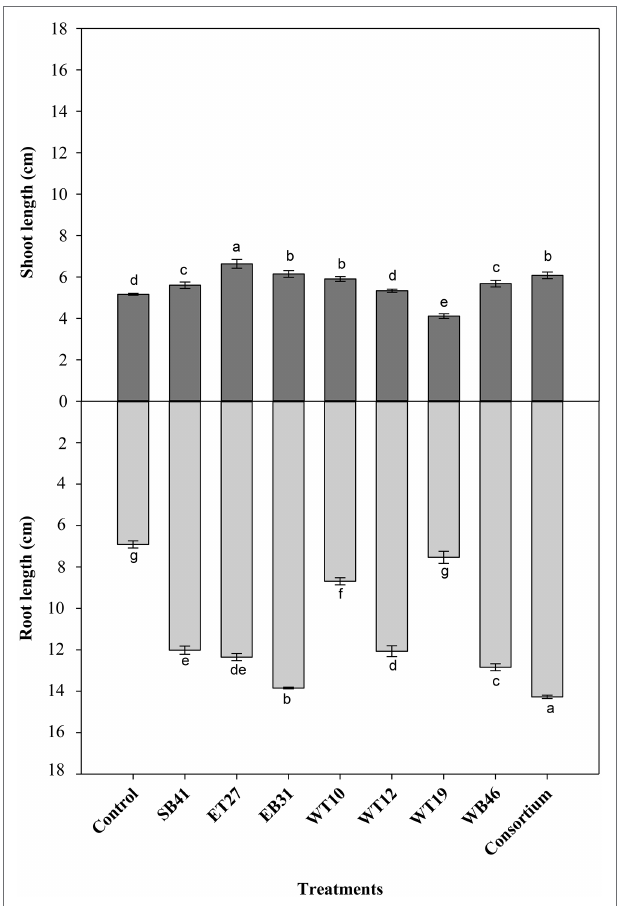
FIGURE 5 | Effect of selected PGPR bacterial strains on root and shoot length (cm) of canola plants measured after 7 days of growth in the presence of 2% n -hexadecane. Error bars represent SDs, and different letters indicate significance according to Tukey’s post-hoc test at p ≤